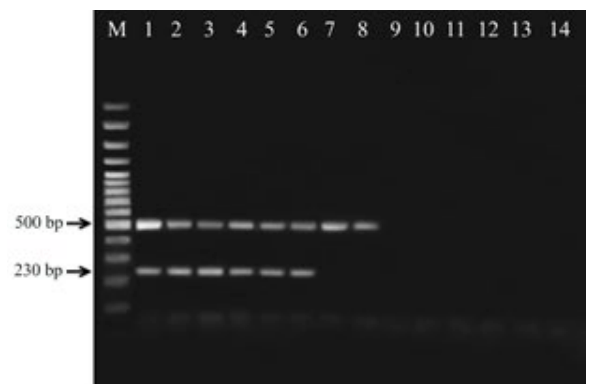
Figure 3. Multiplex PCR using the combination of the Toninia minima -specific primer set (PmaleoF/PmaleoR) together with PmaleoMat1-2F/PmaleoMat1-2R for the si- multaneous identification of T. minima and determination of mating type allele. Lane M, 100 bp DNA ladder; lanes 1‒8, the PmaleoF/ PmaleoR primer set amplifies a 500 bp sized band from all T. minima isolates; the Mat1-2 primer set amplifies a 230 bp band only from Mat1-2 isolates of T. minima (lanes 1–6); Lane 7-8, Mat1-1 isolates of T. minima (no amplicon with Mat1-2 primer set); Lane 9, Pm. irani- anum ; Lane 10, T. fraxinopennsylvanica ; 11, T. krajdenii ;